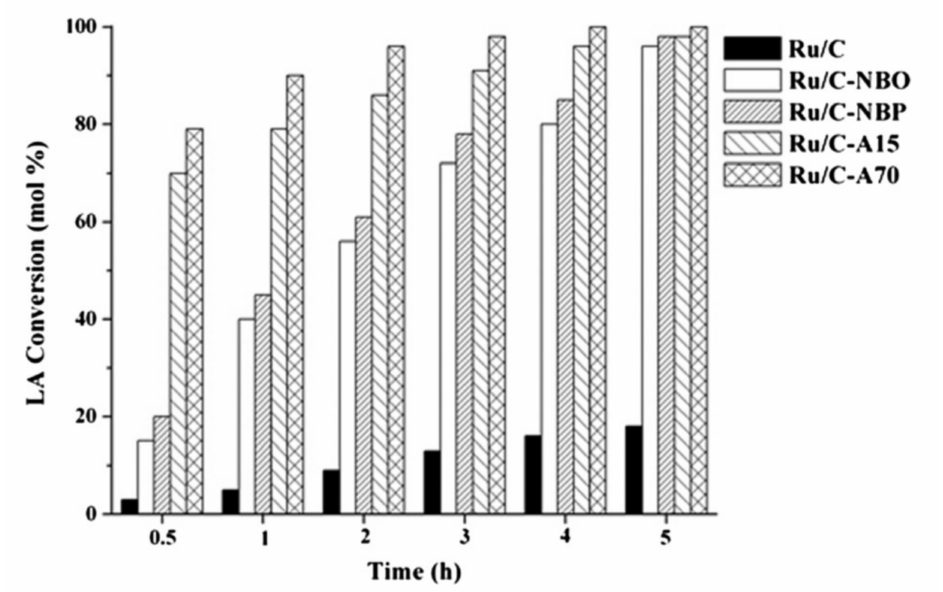
Figure 4. Effect of different heterogeneous acid co-catalysts on levulinic acid (LA) conversion (mol%) vs. time (h), employing 5% Ru/C under mild conditions. Reproduced from ref [56] with permission from The Royal Society of